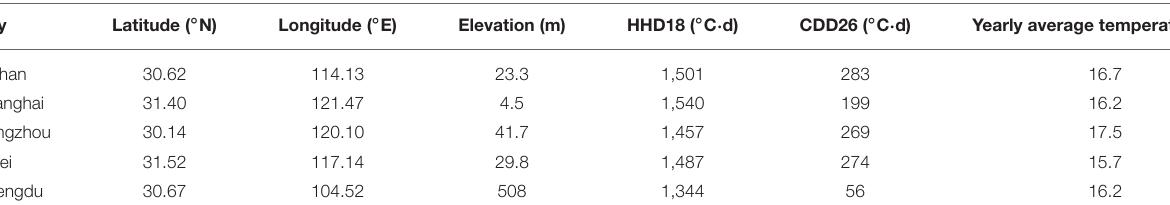
TABLE 4 | Basic climatic information for the five selected cities.